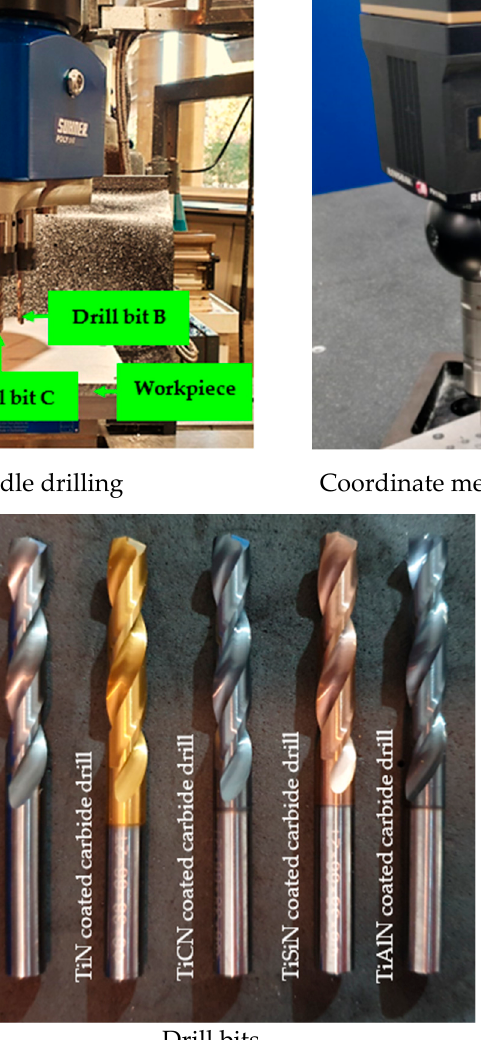
Figure 1. Experimental setup.